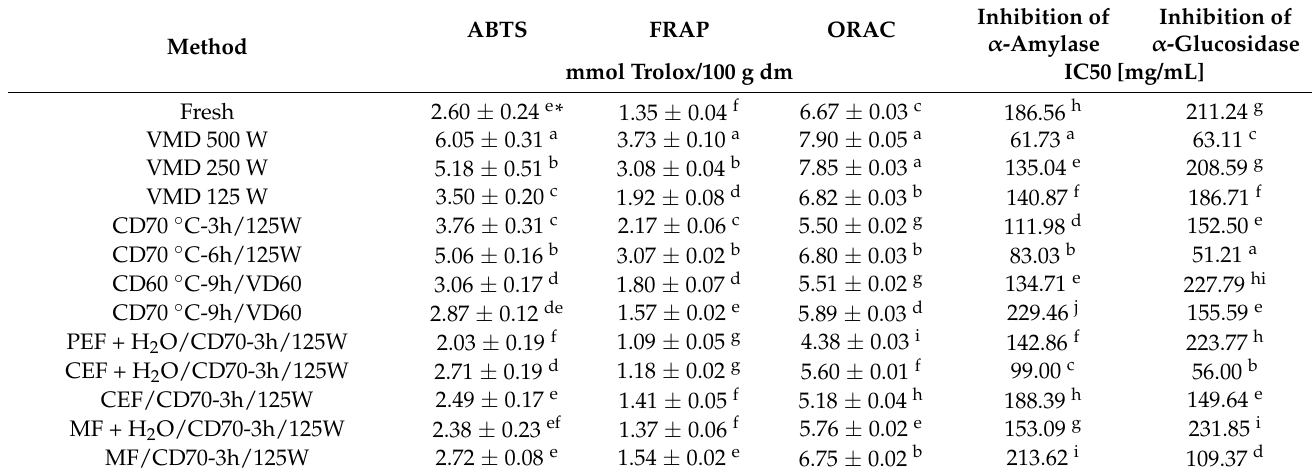
Table 4. Antioxidant, and antidiabetic potential of black garlic dried by different